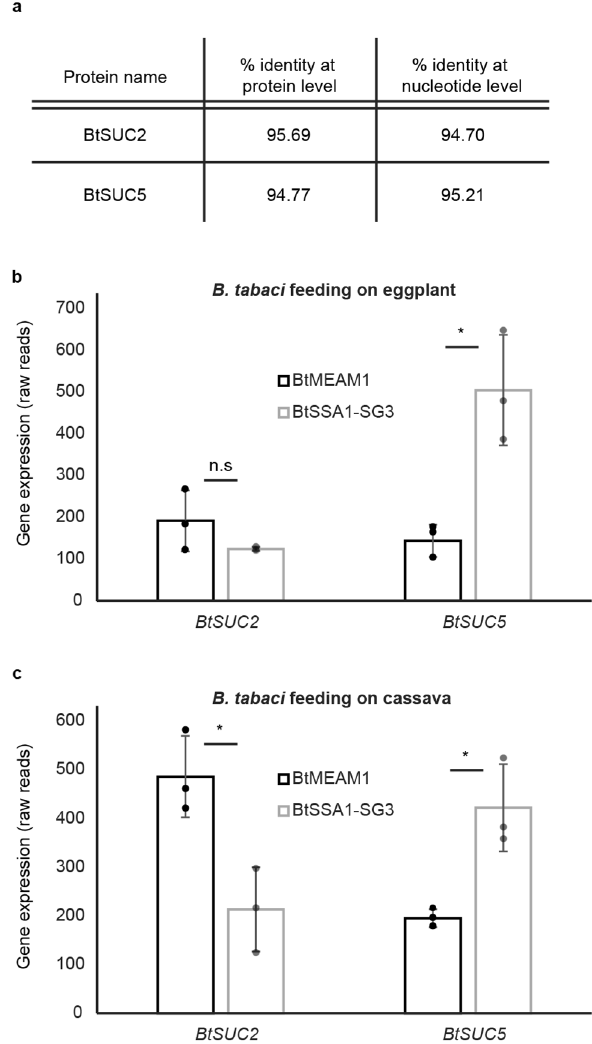
Figure 6. Comparison of transglucosidase BtSUC2 and BtSUC5 sequences in B. tabaci species and relative gene expression in different species on different food plants. ( a ) The percent sequence identities of SSA1-SG3 homologues of BtSUC2 and BtSUC5 to the originally isolated genes from BtMEAM1 were determined at the DNA and protein levels. ( b , c ) Mean numbers of reads mapped to BtSUC2 and BtSUC5 were plotted in the species BtMEAM1 and BtSSA1-SG3 feeding on two host plants, eggplant and cassava. Asterisks denote statistically significant differences (p value < 0.05) between means of biological replicates (N = 3) with individual data overlaid as points on the